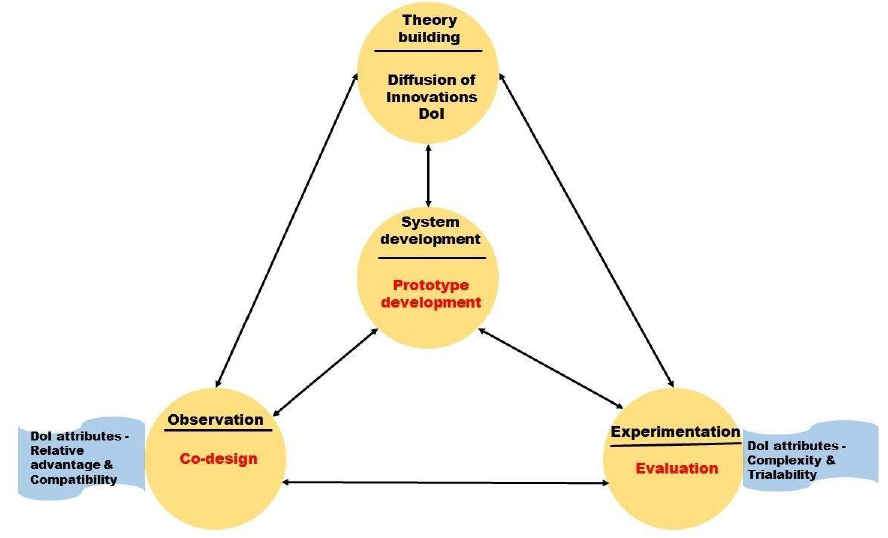
Figure 1. Phases of the study. Adapted Methodological framework [19].